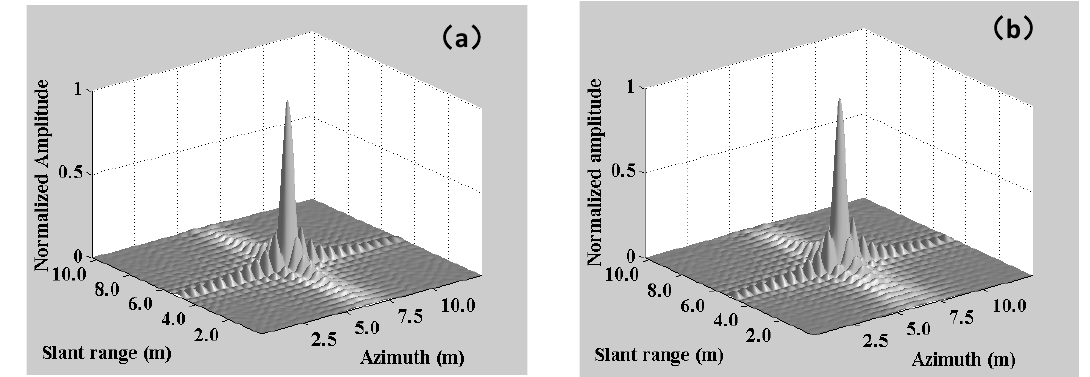
Figure 8. 3D response of the ( a ) center scatter and ( b ) edge scatter after the proposed motion error compensation.